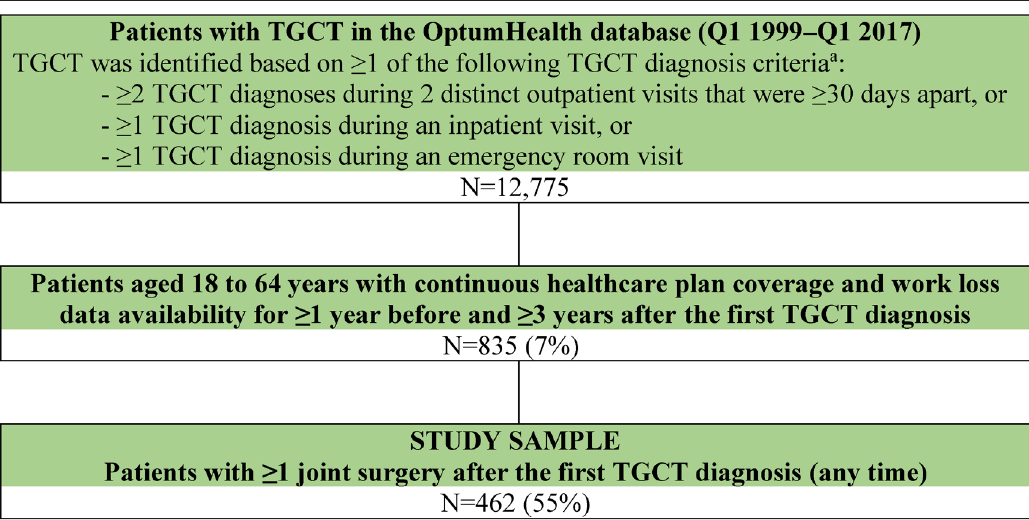
Figure 1. Selection of Study